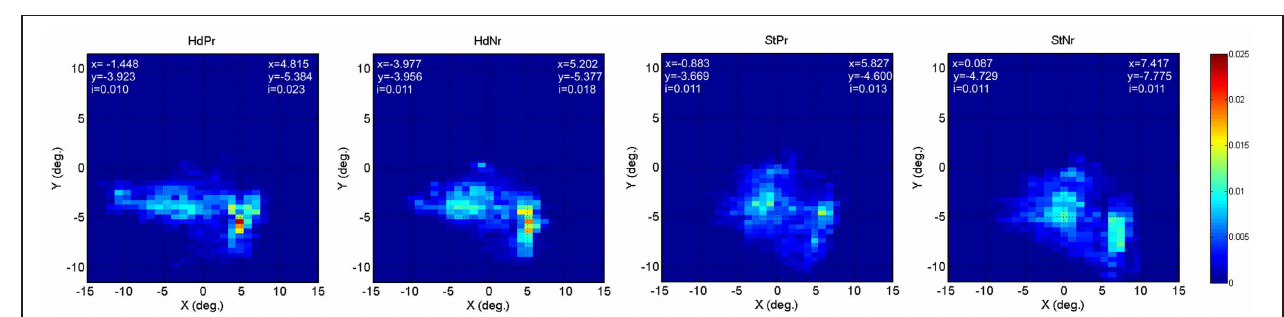
FIGURE 5 | Heat maps depicting relative eye gaze location (screen x ◦ /y ◦ ) during HeadingPv, HeadingNr, SteerPv, and SteerNr trials. Details of precise peak x and y positions for each visual hemifield are provided for each